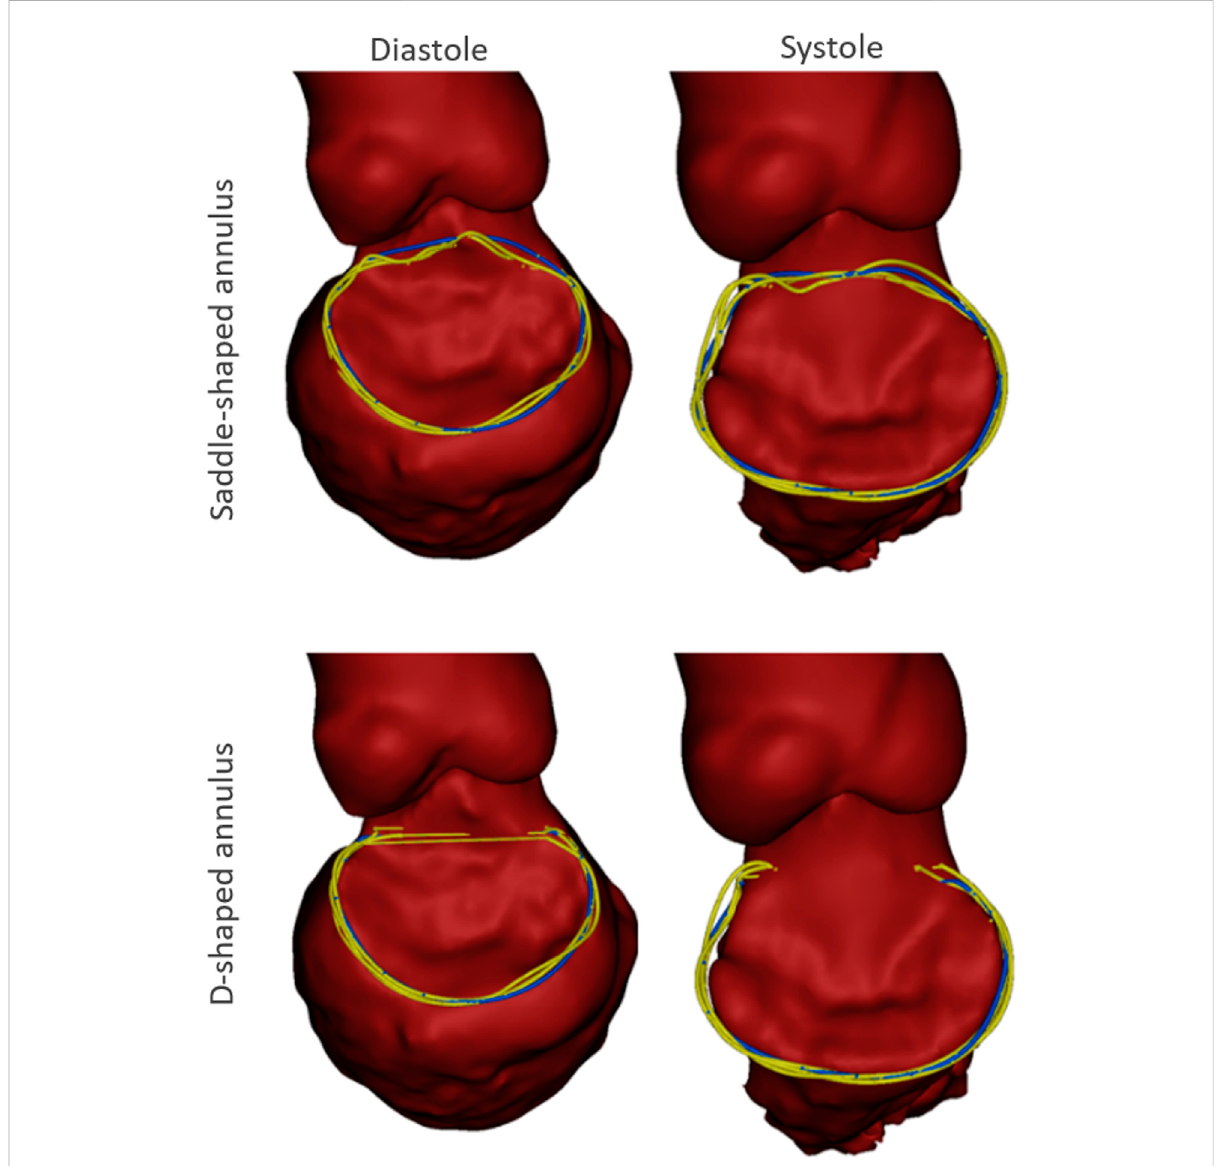
FIGURE 5 Example case with the manual annulus curves displayed in yellow and the automatically predicted annulus represented in blue, for both the saddle- (Top) and D-shaped (bottom) con fi gurations, as well as for the diastolic(left) and systolic (right) phase. The LA was excluded for visualization